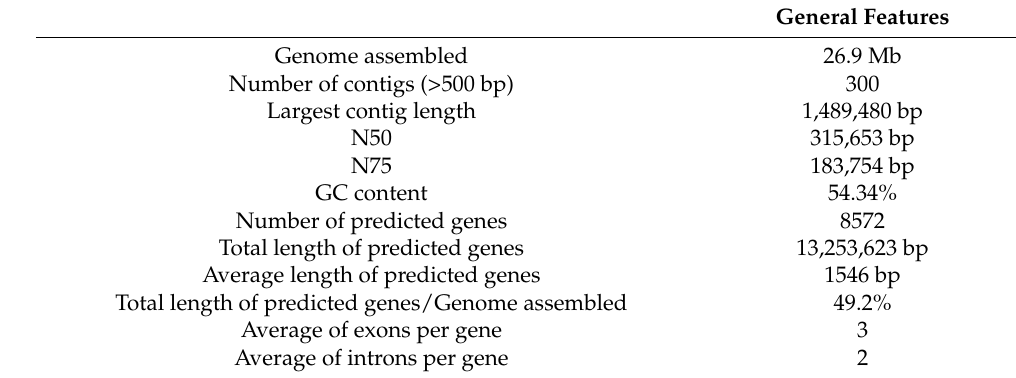
Table 1. General statistics of the Emericellopsis cladophorae MUM 19.33 genome assembly, and gene prediction.